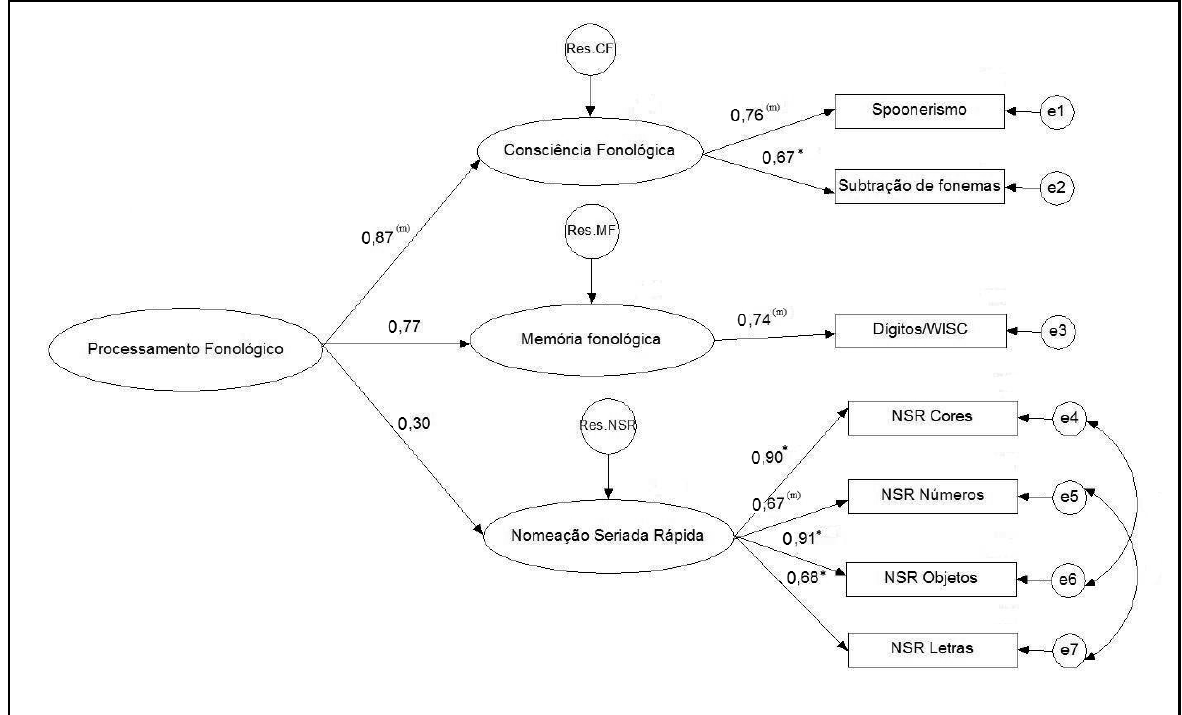
Figura 2. Diagrama do modelo com um fator de segunda ordem (representação da proposta de Wagner & Torgesen, 1987). Nota : NSR = nomeação seriada rápida; (m) = métrica; * p <